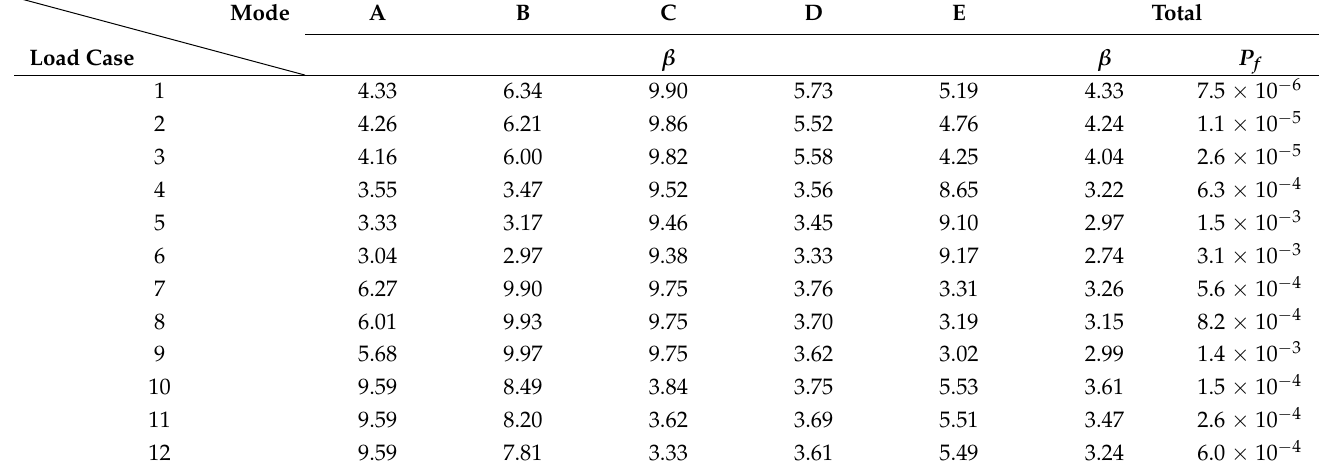
Table 10. Reliability calculation results of the local connection nodes of the semi-submersible platform.